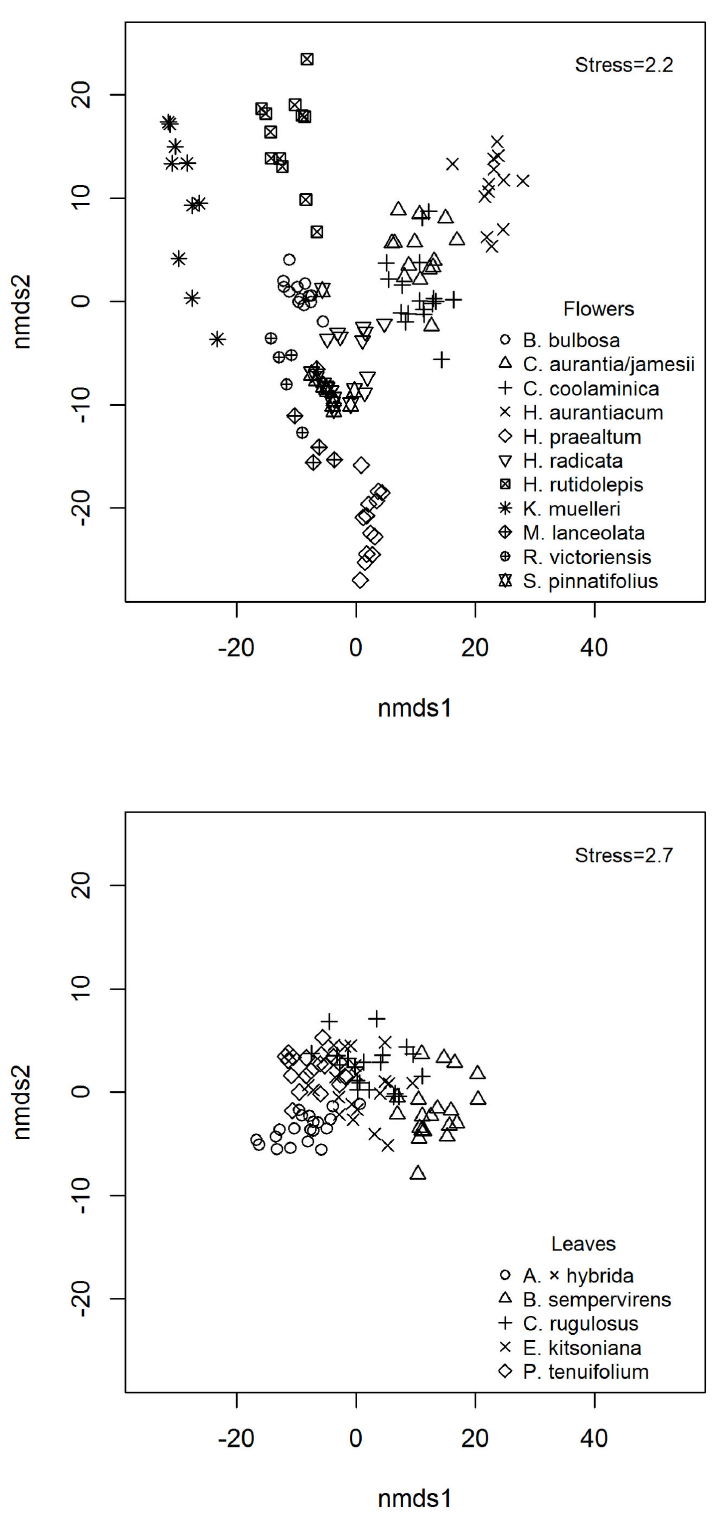
Figure 1. Leaf and flower colour difference. Pairwise Euclidean distance in CIE 1976 (L*a*b*) space was calculated and an nMDS generated for a) yellow-orange flowers and b) leaves (the leaf nMDS used data from the two highest quality cameras only: the Nikon D300 and Sony NEX-5n). doi: 10.1371/journal.pone.0072296.g001 PLOS ONE |